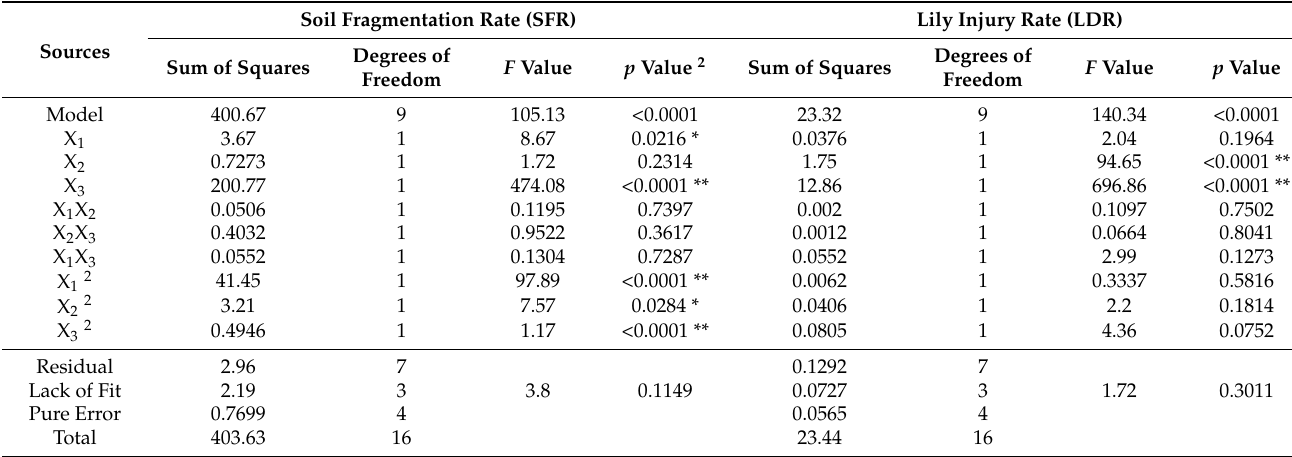
Table 4. Variance analysis of regression